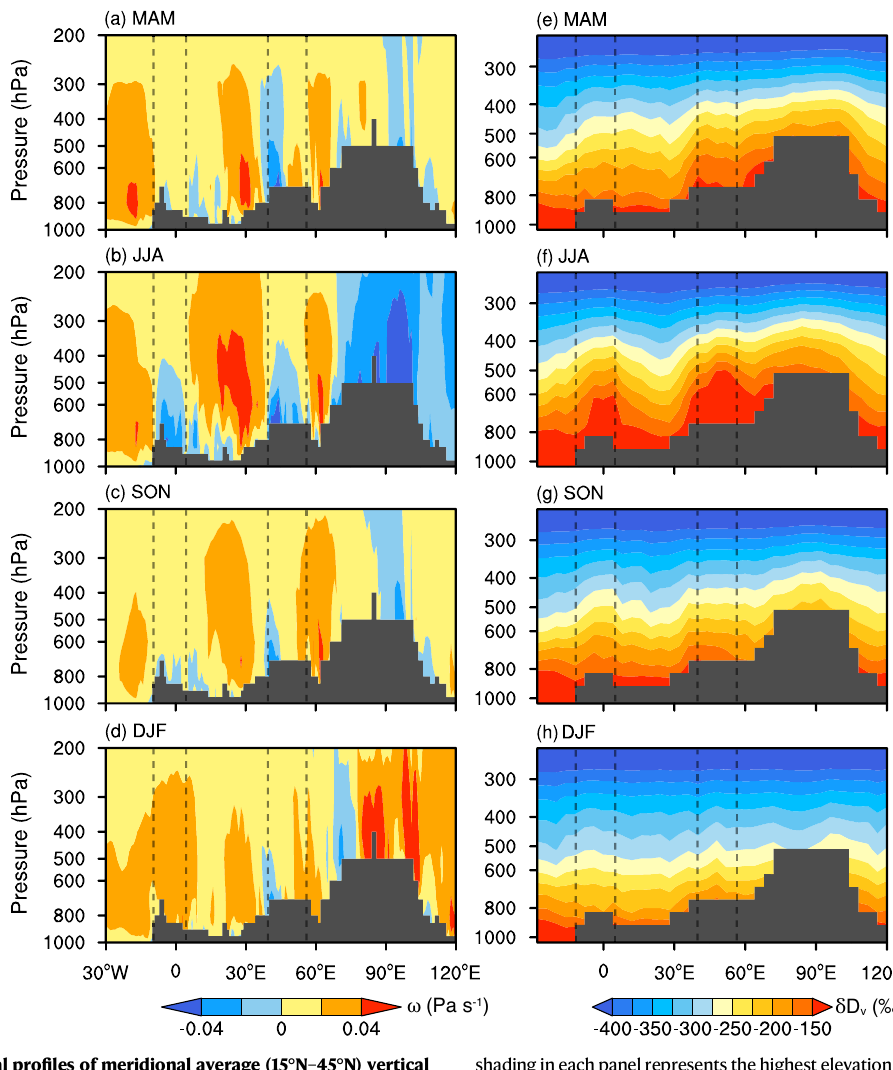
Fig. 6 | Seasonal vertical pro fi les of meridional average (15°N – 45°N) vertical velocities ( ω ) and δ D v over the Asian drylands and surroundings during 2006 – 2009. a – d Vertical velocities based on ERA5 reanalysis. e – h δ D v based on TES retrievals. The dashed lines in each panel represent the longitudinal range of the area where the vertical upward movement is strongest in summer. The